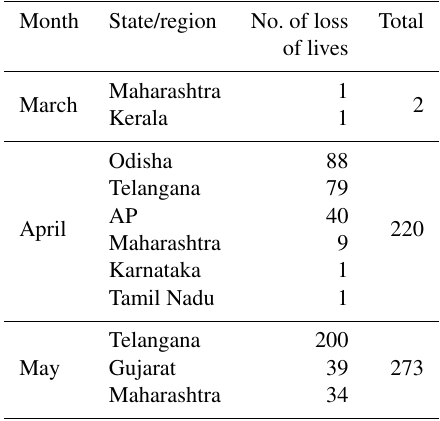
Table 1. Casualties reported during March to May 2016 due to pre- vailing heatwaves over